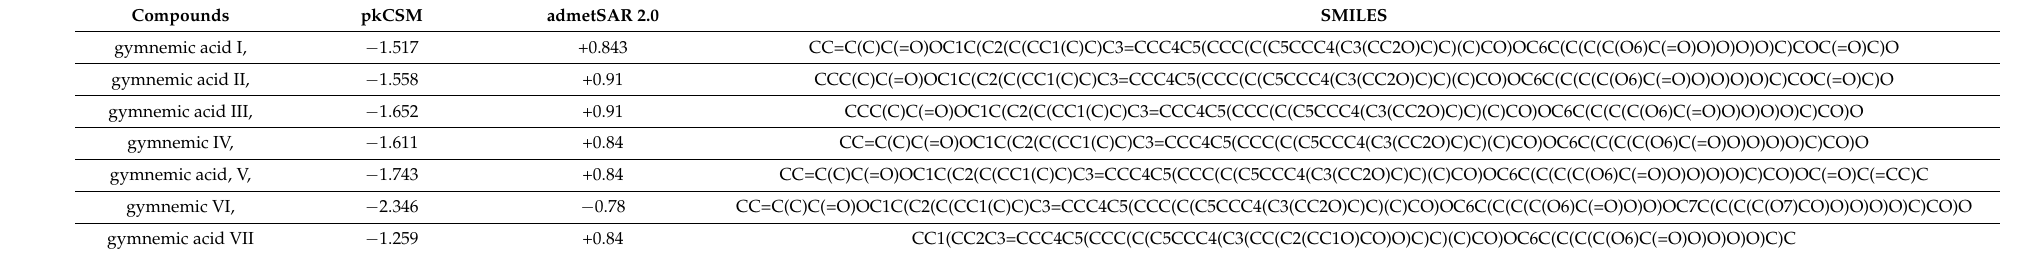
Table 3. Predicted BBB permeability of gymnemic acids I-VII using pkCSM [189] (sourced from pkCSM-parmacokinetics web server [191]) and admetSAR2.0 [190] (sourced from admetSAR web server [192]). Their SMILES codes of the compounds are given as